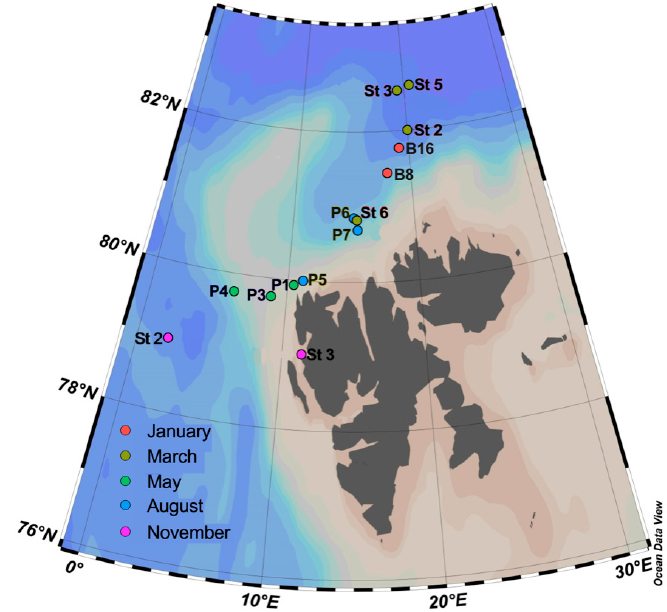
Figure 1. Sampling stations during the five cruises performed in 2014. Symbol colors are uniform for sampling month, whereas station labels indicate the names of sampling stations. The same color scheme is utilized throughout this study.